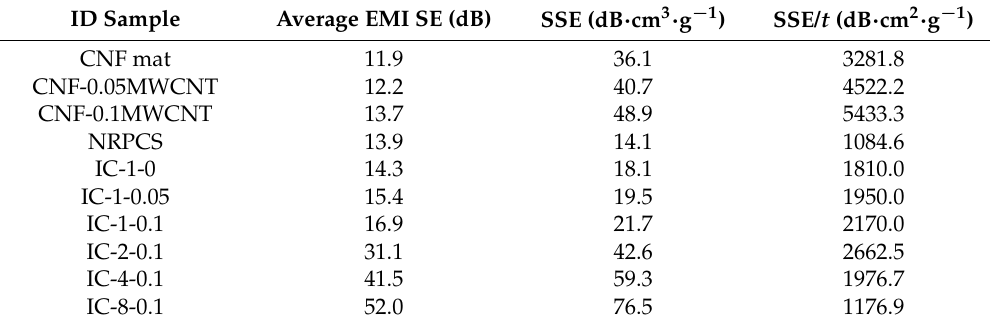
Table 3. Values of average EMI SE, specific SE (SSE), and absolute shielding effectiveness (SSE/ t ) of produced